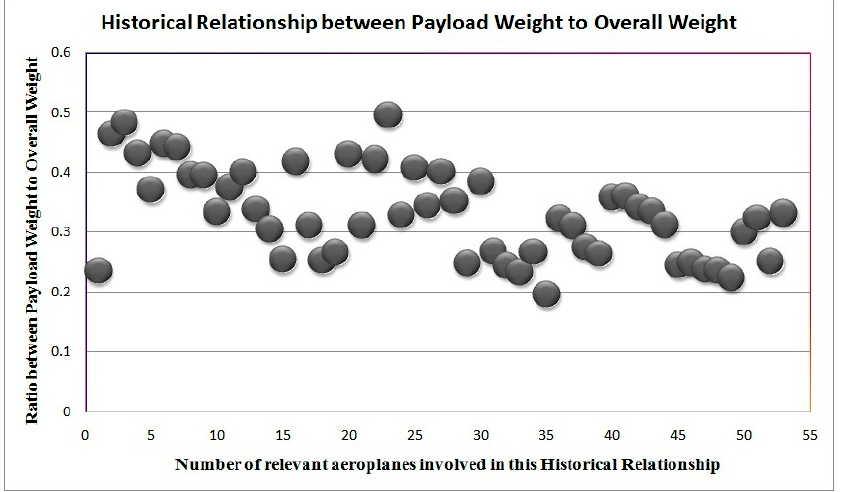
Figure 2. Comprehensive historical relationship between payload and overall weights of relevant aircraft.